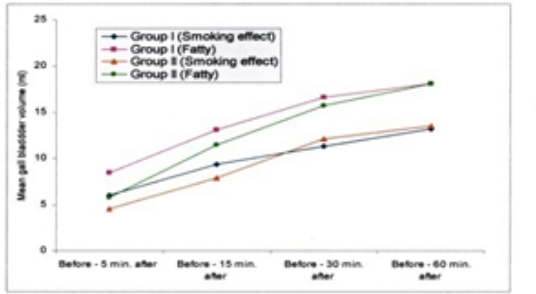
Fig 1. Net change of gallbladdar volumes (in cm 3 ) between before and after smoking and fatty food intake in both